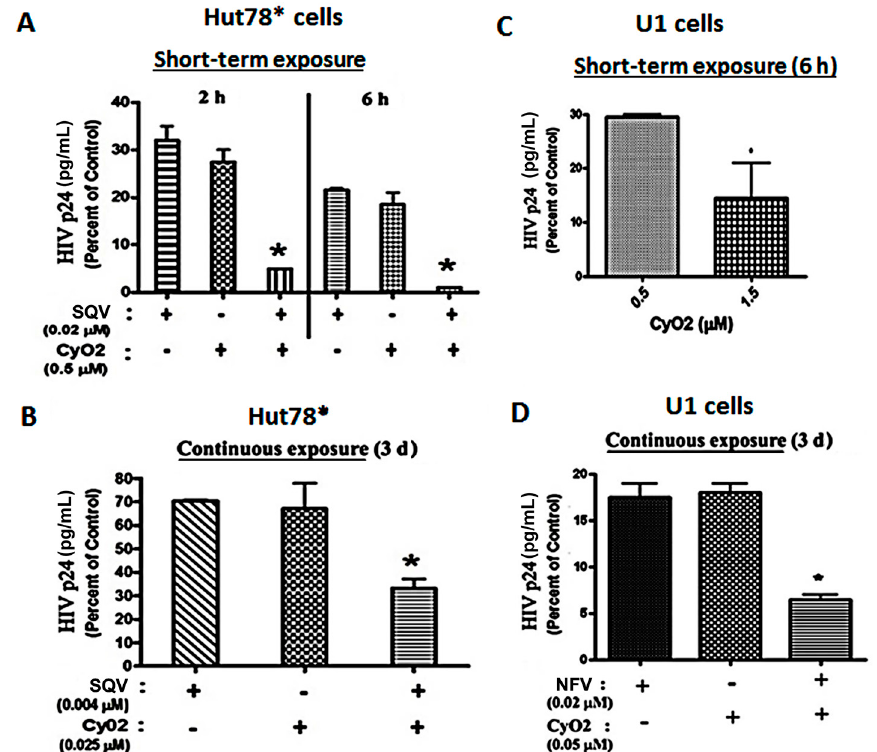
Figure 4. Anti-HIV effects of CyO2, alone and in combination with PIs. In ( A , B ), the effects of CyO2 and/or SQV is shown in HIV-1 infected HuT78* cells. HIV-1 p24 levels at 3-days post-infection, following either ( A ) short-term (2–6 h) exposure to SQV (0.02 µ M) and/or CyO2 (0.5 µ M) or ( B ) following continuous exposure (72 h) to SQV (0.004 µ M) and/or CyO2 (0.025 µ M), are shown. In ( C , D ), the effects of CyO2 and/or nelfinavir (NFV), in HIV-1 infected U1 cells are shown. The p24 levels at 3-days, following either ( C ) short-term (6 h) exposure to CyO2 (0.5 and 1.5 µ M); ( D ) continuous exposure (72 h) to NFV (0.02 µ M) and/or CyO2 (0.05 µ M) are shown. Bar graphs show normalized HIV-1 p24 levels (pg/mL) in culture supernatants and are represented as a percent of control (untreated cells). Error bars show +/- standard error of means (SEM) from 3–4 independent experiments. Significant changes from control are shown as p -values (*, p < 0.05). Exposure to CyO2 alone decreased virus production and coexposure to CyO2 increased the anti-HIV efficacy of two different PIs, SQV and NFV.